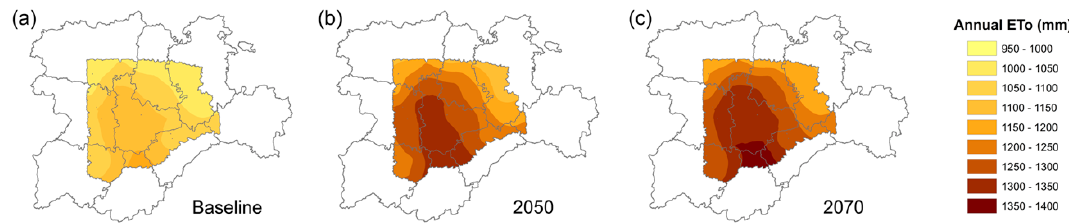
Figure 3. Spatial distribution of annual evapotranspiration (ET 0 ) in the area of study for the ( a ) baseline, ( b ) 2050, and ( c ) 2070 scenarios.